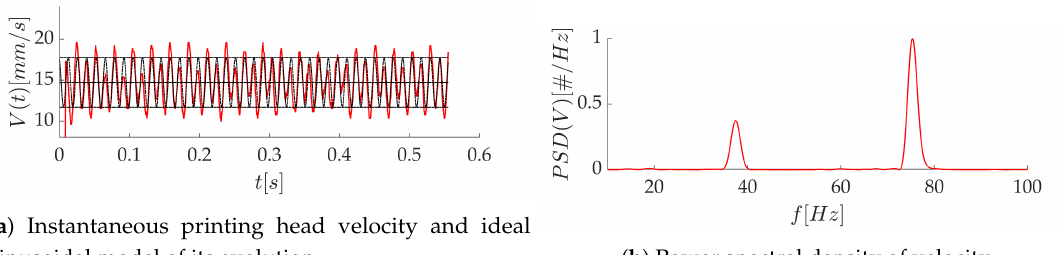
Figure 20. Time evolution of the printing head velocity and frequency analysis.